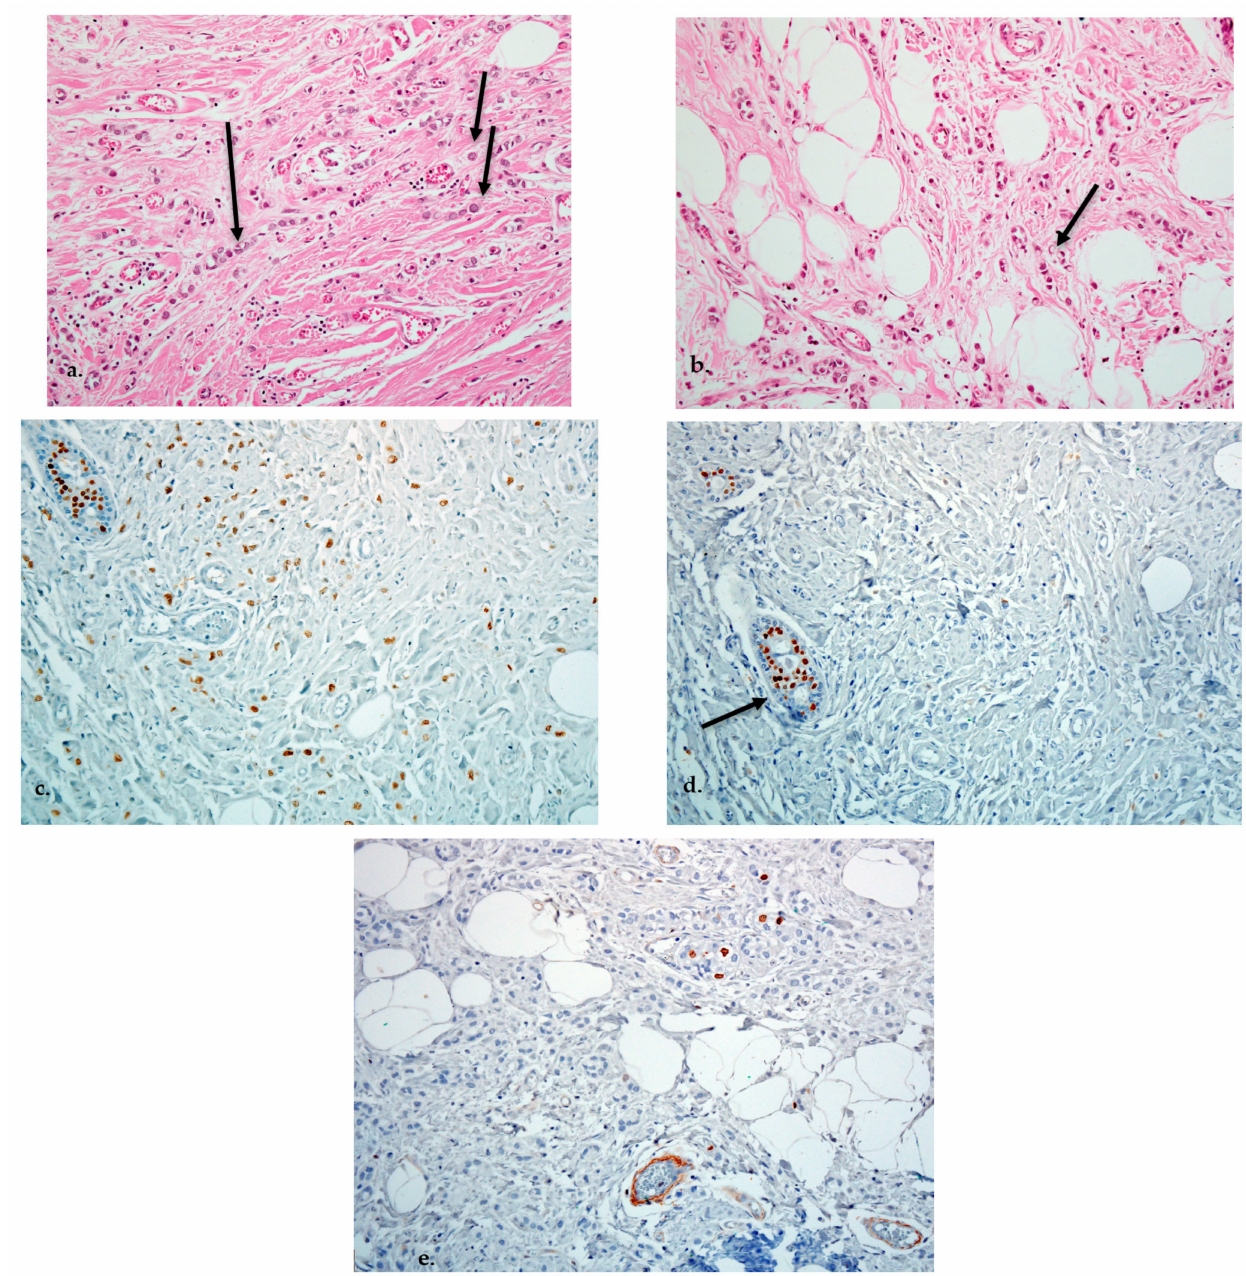
Figure 5. ( a ) Invasive lobular carcinoma: isolated tumor cells and “indian file” arrangement (arrows) (H and E staining 20 × ) . ( b ) Some invasive tumor cells have signet-ring cell morphology (arrow) (H and E staining 20 × ) . ( c ) High expression of estrogen receptor (ER) in the nuclei of tumor cells. 20 × . ( d ) Absence of progesterone receptor (PR) in the tumor cells (internal positive control − benign glands − arrow) × 20. Anti-PR 20 × . ( e ) Low proliferative activity. Anti-Ki-67 20 ×